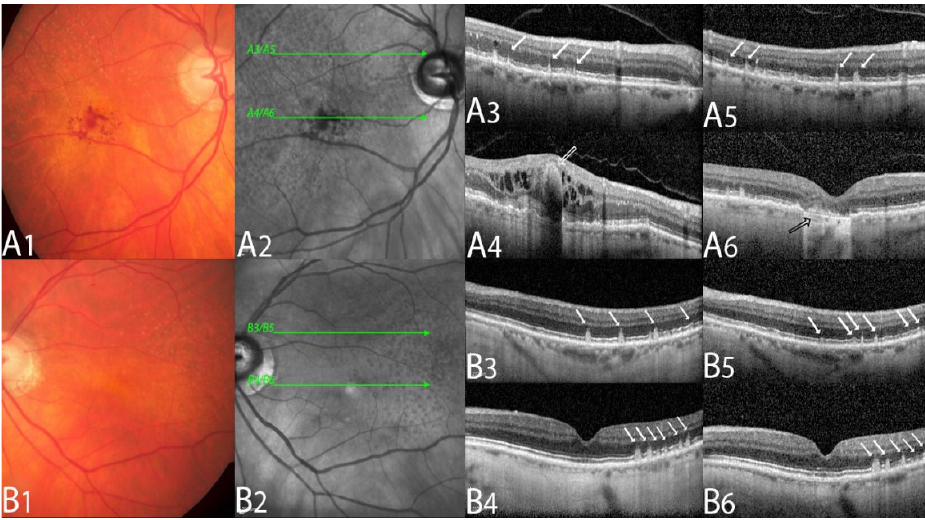
Figure 2. Multimodal imaging example of a type 3 macular neovascularization.